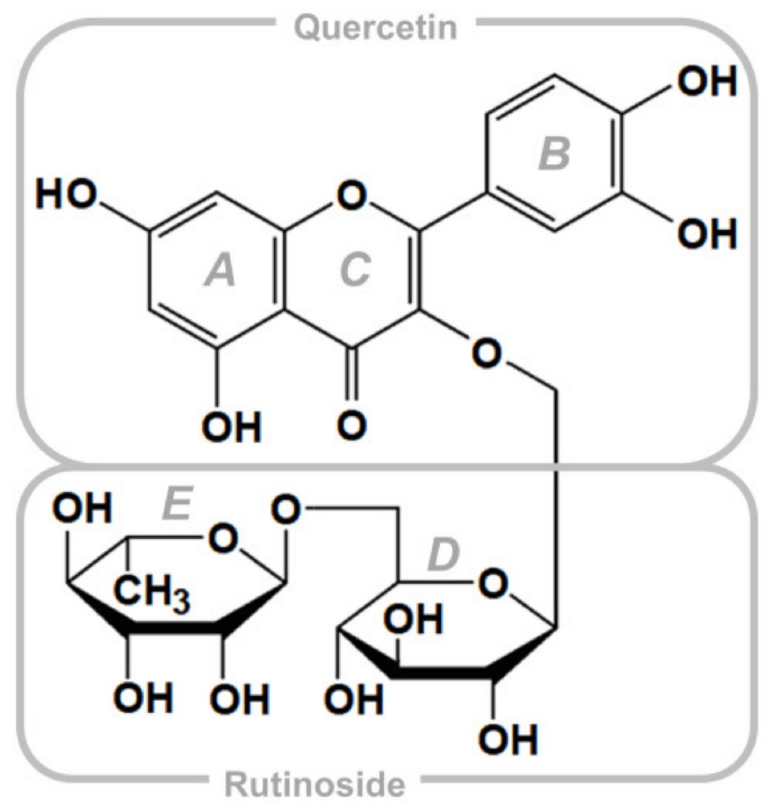
Figure 1. Chemical structure of rutin, with the quercetin scaffold (3,3 (cid:48) ,4 (cid:48) ,5,7-pentahydroxyflavone) and the rutinoside moiety ( α -l-rhamnopyranosyl-(1 → 6)- β -d-glucopyranose). Rings ( A – E ) are la- belled according to standard